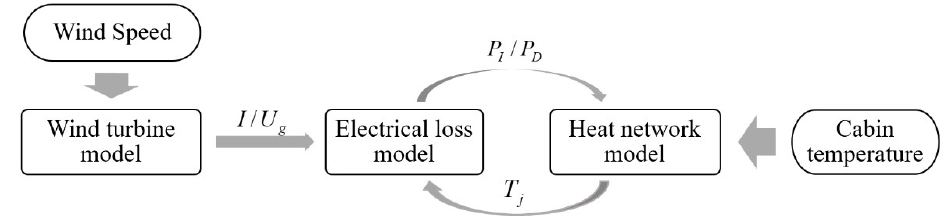
Figure 4. Junction temperature calculation process.